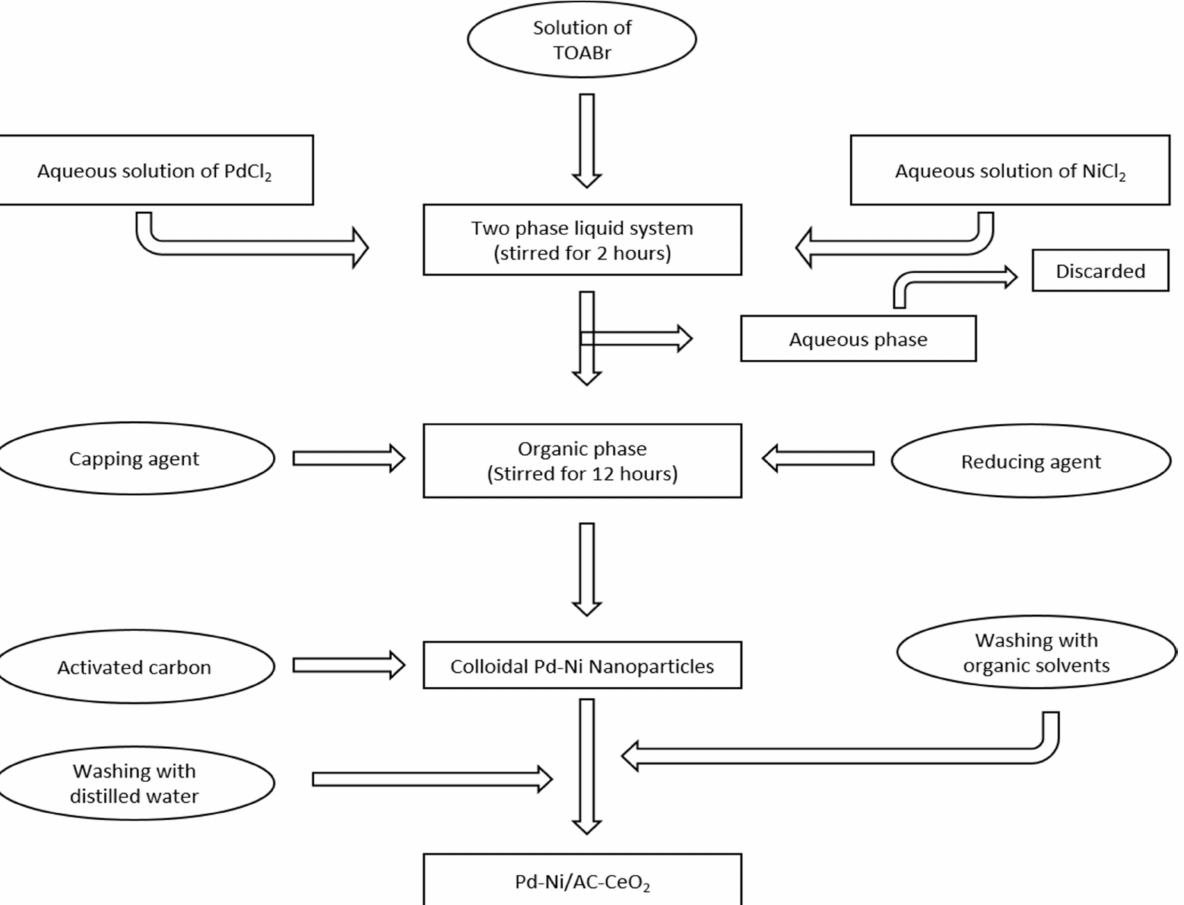
Figure 2. Preparation of Pd-Ni bimetallic